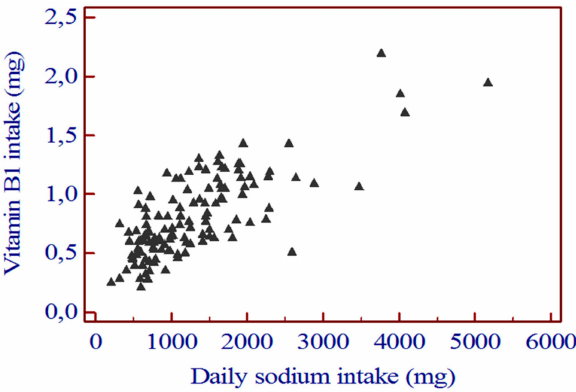
Figure 3. Correlation between daily sodium intake and daily vitamin B1. r = 0.763 [0.679 to 0.827]; p <